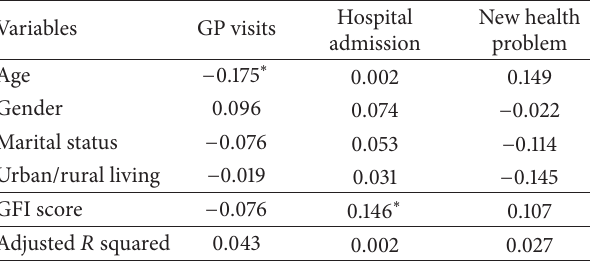
Table 2: Final models of stepwise linear regression analysis with frailty scores by Groningen Frailty Indicator (GFI) as predictive variable and visits to the general practitioner (GP) and hospital admission over the last year as outcome variables (standardized coefficients beta are